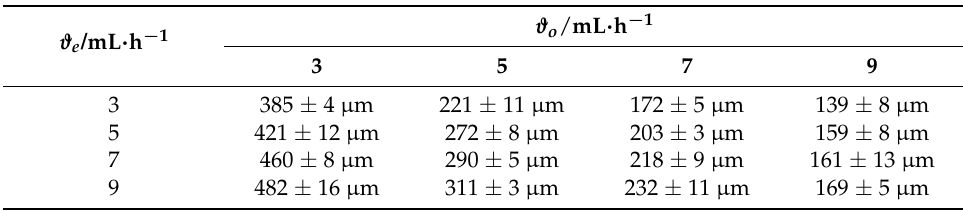
Table 3. Diameter of microcapsules versus flowrate of continuous (3 mL · h − 1 –9 mL · h − 1 ) and dispersed phases (3 mL · h − 1 –9 mL · h − 1